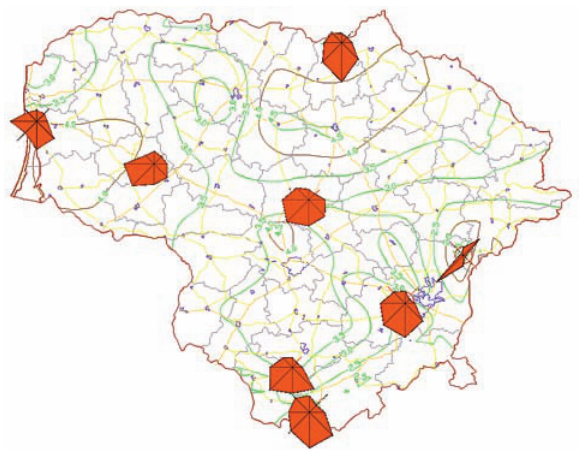
Fig. 2. The map of the average wind speed with wind roses Fig. 3. Distribution of the max depth of frozen ground in the territory of Lithuania based on RWIS